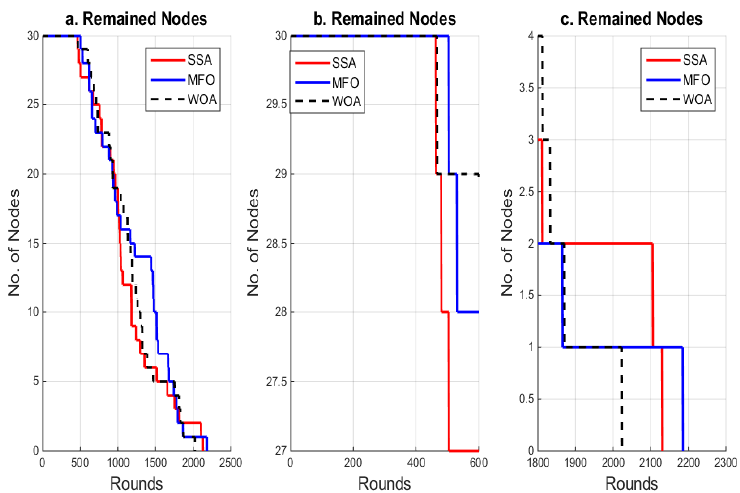
Figure 3. The number of rounds versus the number of alive nodes in MFO, SSA and WOA.